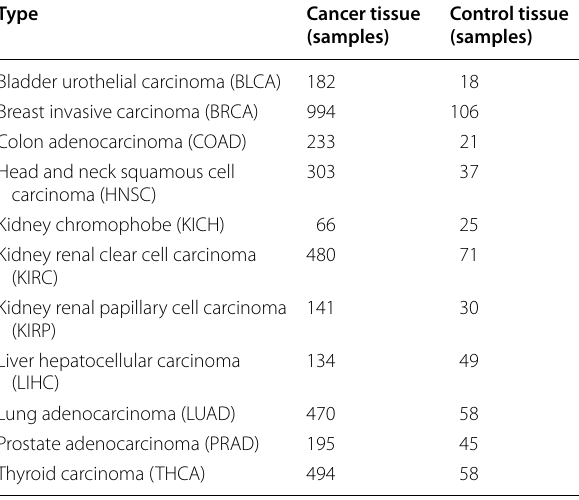
Table 1 Sample sizes of RNA-seq data for 11 cancer types Type Cancer tissue